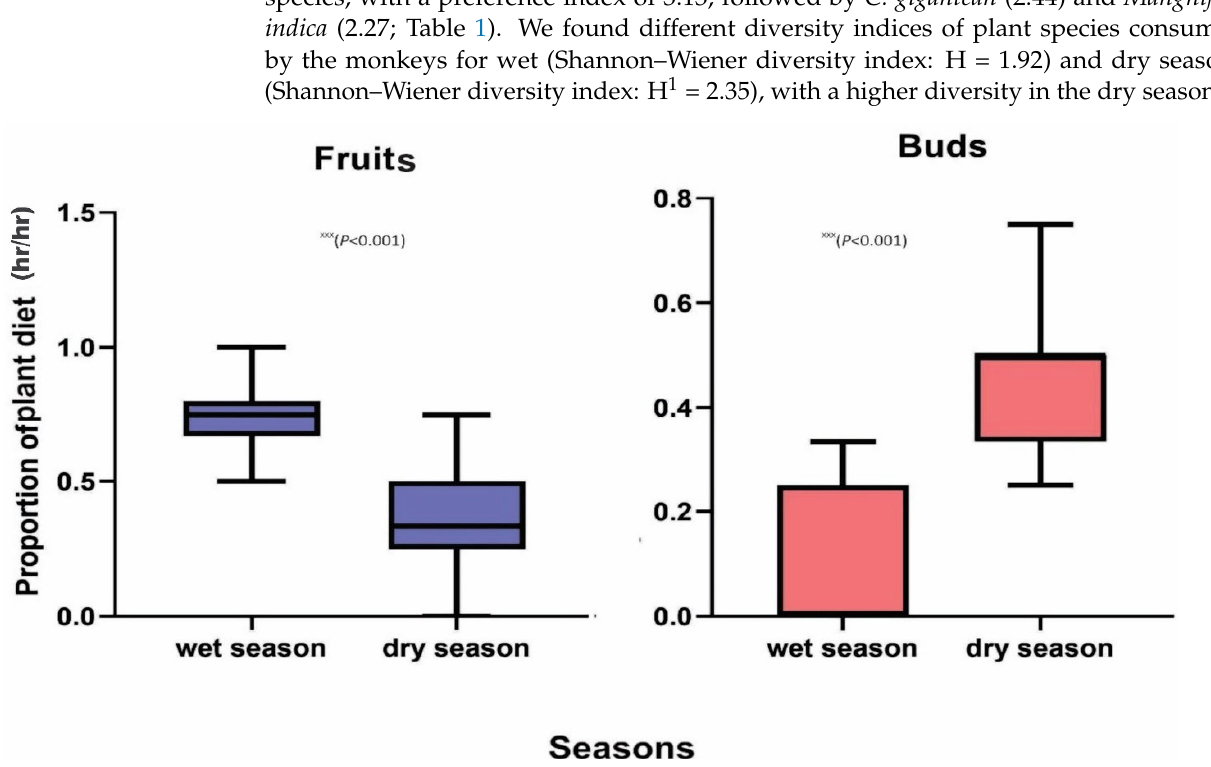
Figure 4. Proportion of fruit ( p < 0.001) and buds ( p < 0.001) consumed by Lowe’s monkeys in wet and dry seasons in the Duasidan Monkey Sanctuary, Ghana ( xxx p < 0.001). The line in the boxes represents a median value while the boxes represent interquartile ranges and whiskers represent the range of minimum and maximum values. Table 1. Preference indices of plant species consumed by Lowe’s monkeys in the Duasidan Monkey Sanctuary, Ghana.